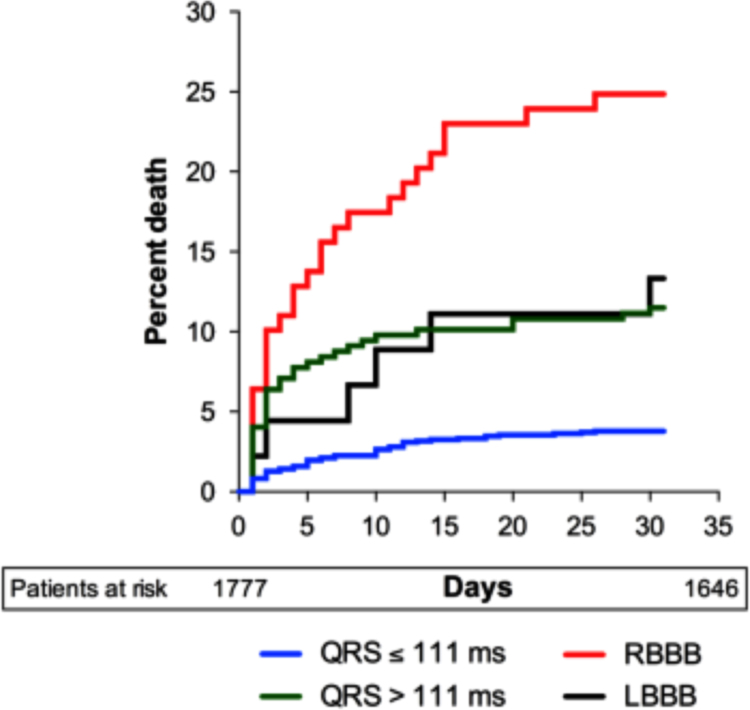
Kaplan Meier survival curve, in patients with suspected ST segment elevation myocardial infarction categorized according to QRS duration and bundle branch block on prehospital electrocardiogram.